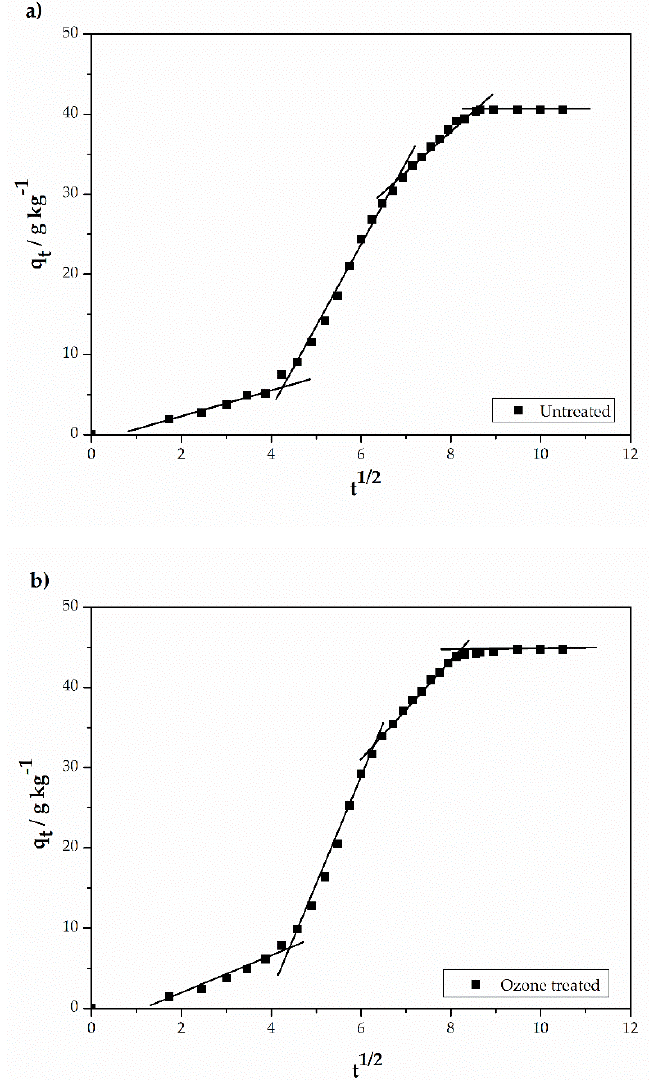
Figure 5. Intra-particle kinetic diffusion for dye adsorption in ( a ) untreated and ( b ) ozone-treated polyester.